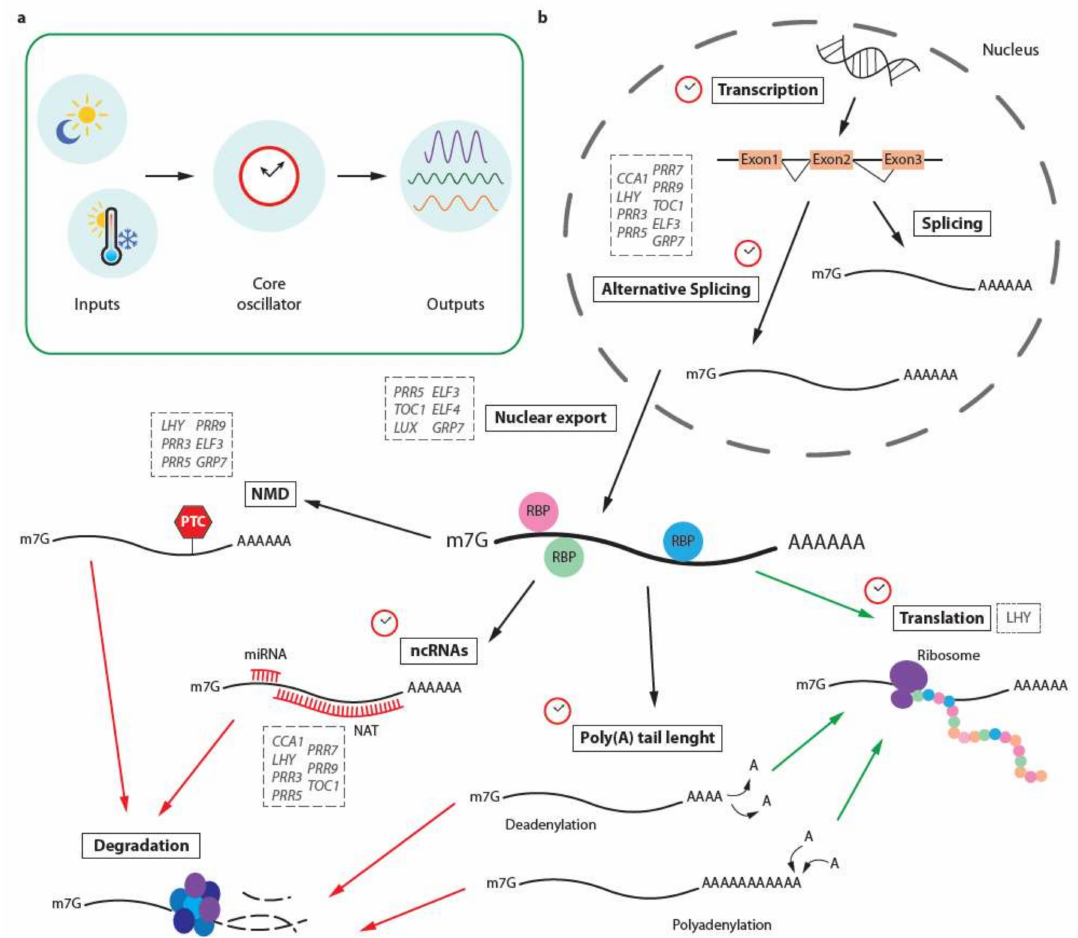
Figure 1. Crosstalk between the circadian clock and post-transcriptional regulatory pathways. ( a ) Environmental signals such as light and temperature (referred to as clock inputs) are integrated by a central oscillator consisting of clock proteins. This core oscillator integrates environmental signals with the endogenous status of the organism and in turn modulates and coordinates a wide range of mechanisms known as “outputs” of the clock. ( b ) Post-transcriptional regulation pathways are some of the outputs known to be circadianly regulated. In this scheme, the clock symbol indicates which of these steps are known to be regulated in this manner. Green and red arrows indicate pathways leading to translation and degradation, respectively. In addition, gray dashed boxes highlight core clock genes known to be subject to post-transcriptional regulation at various steps of RNA